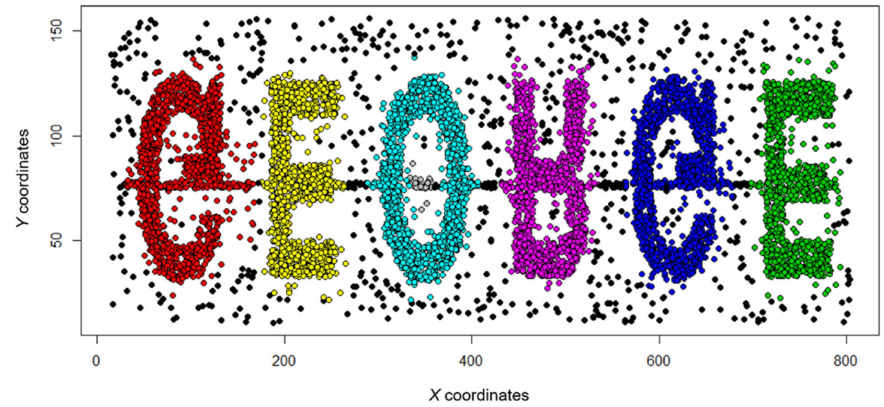
Figure 5. Results of spatiotemporal clustering using 4D + SNN.